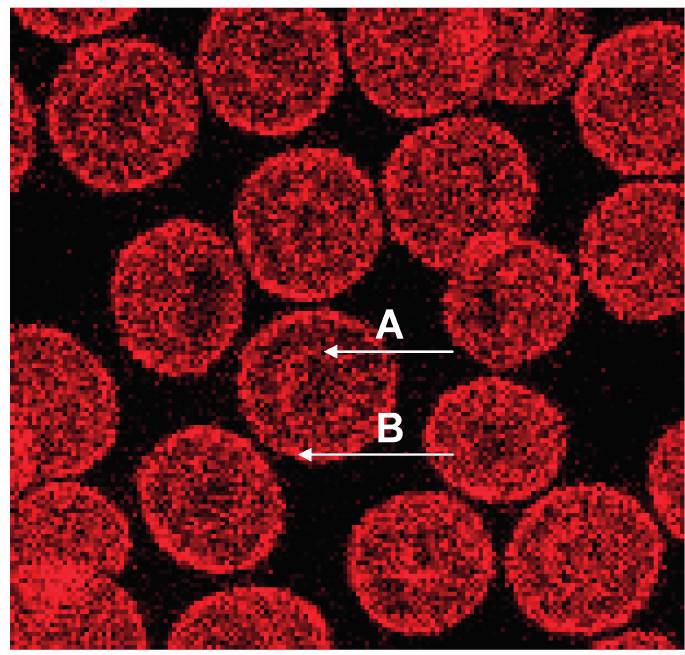
Figure 4. Phalloidin–Rhodamin stained actin in erythrocytes after suspension in autologous plasma; “A” marked arrow pointing at the periphery of the central dip, “B” marked arrow at the cell rim (reprinted from reference [23], Copyright 2013, with permission from IOS Press) (Primary magnification 1:63, zoom factor: